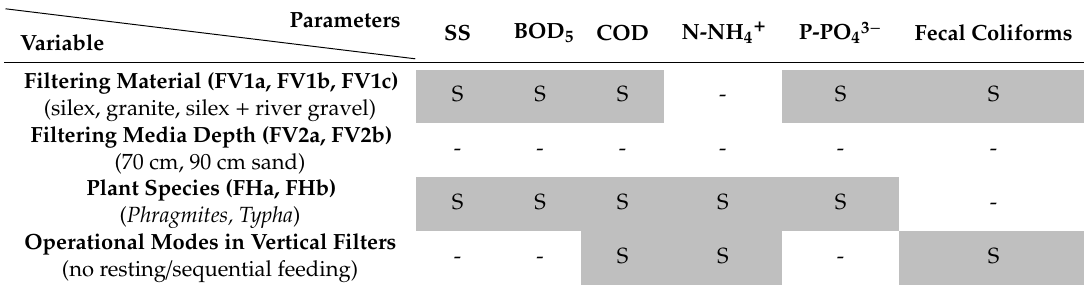
Table 6. E ff ect of the design and operational variables on parameter removal (S = significant e ff ect). Parameters SS BOD 5 COD N-NH 4 + P-PO 43 − Fecal Coliforms Variable Filtering Material (FV1a, FV1b, FV1c)